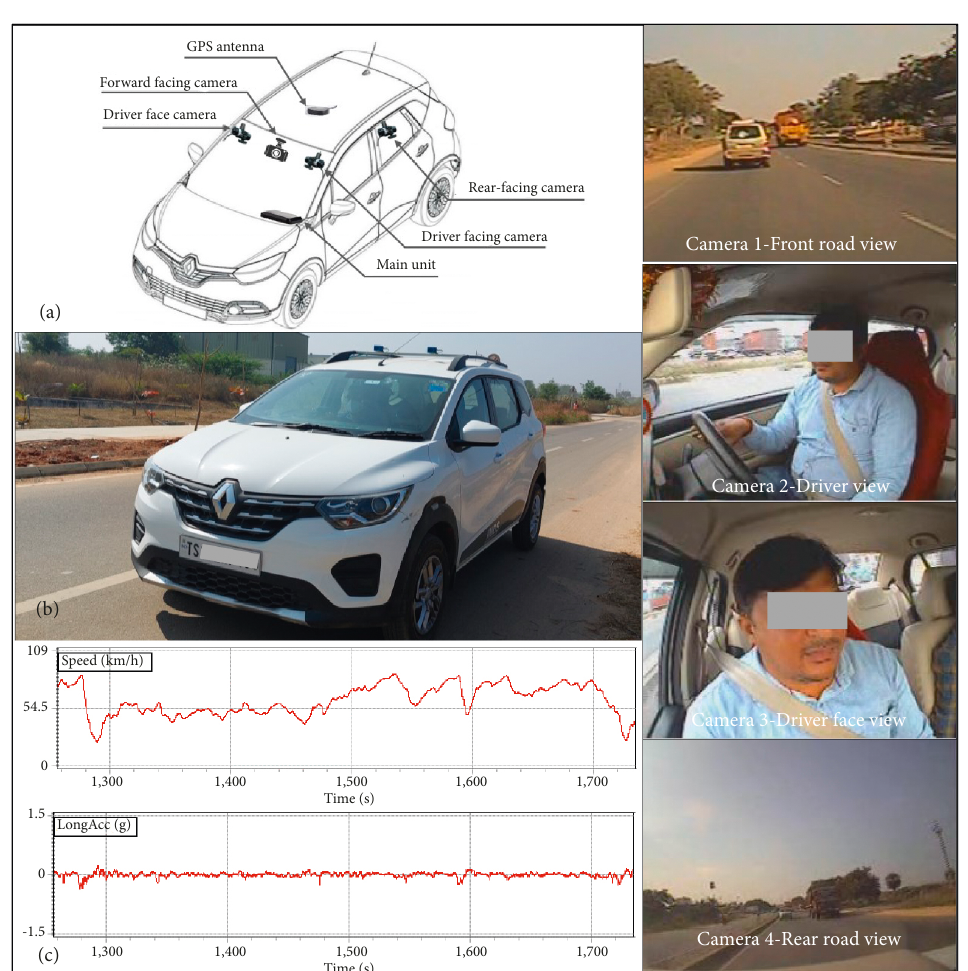
Figure 2: (a) Instrumentation details; (b) Study vehicle; (c) Recorded speed and acceleration profiles; and snapshots of collected video